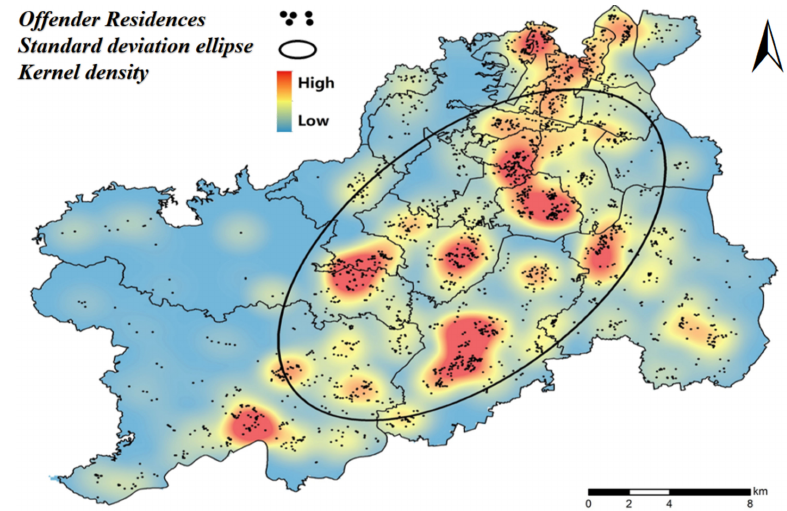
Figure 7. Spatial distribution of offender